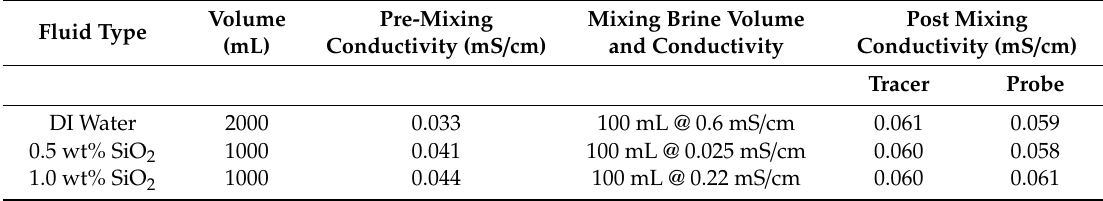
Table 2. The conductivities of flooding fluids both before and after the addition of tracer NaCl solution.